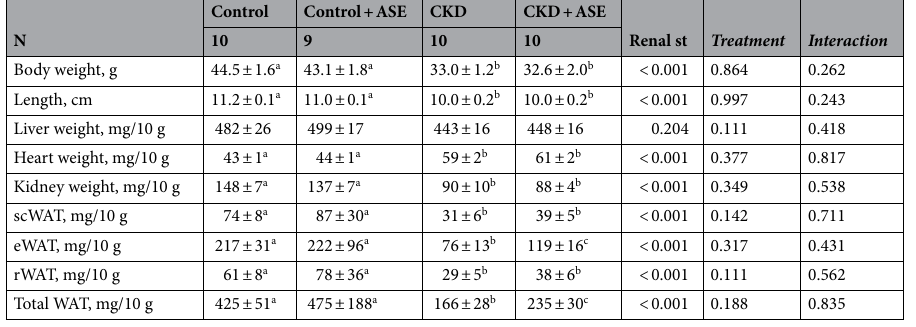
Table 1. Biometric data of experimental mice. Data are expressed as mean ± 1 SD. Significant differences were determined by two-way ANOVA, followed by Tukey’s multiple comparison tests. Different letters indicate